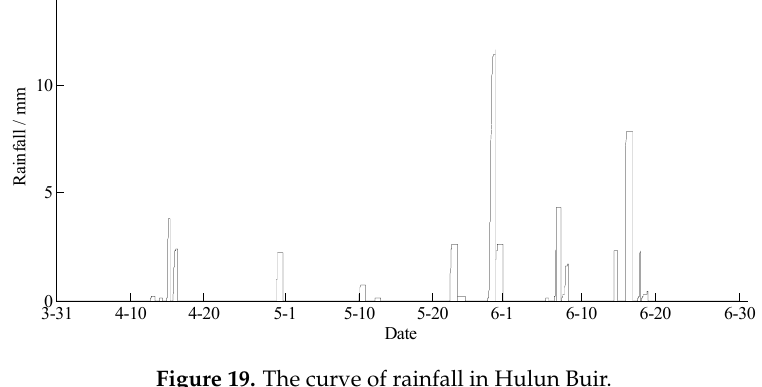
Figure 19. The curve of rainfall in Hulun Buir.